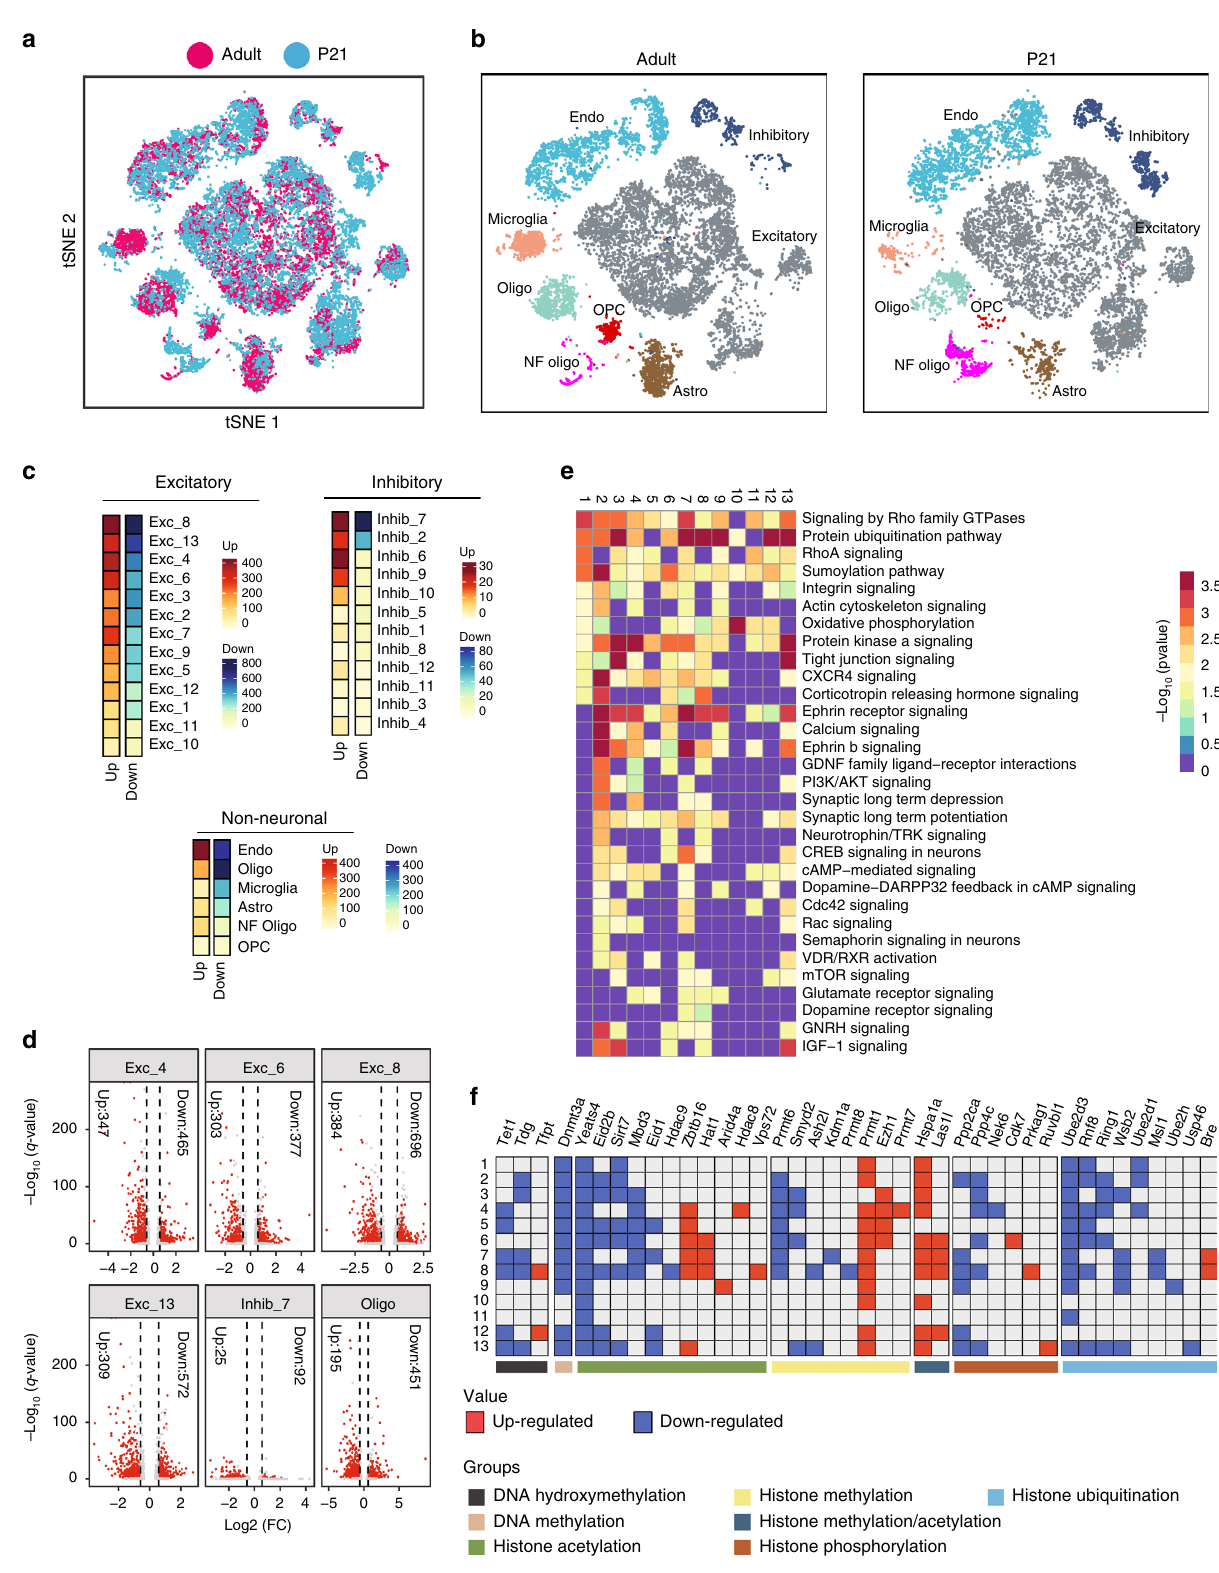
To detect similar populations and identify corresponding cell clusters between the 10,646 P21 cells and the 11, 886 P60 PFC cells, we aligned the two scRNA-seq data sets in t-SNE by cross- correlation analysis (CCA) 17 (Fig. 4a). Using bootstrapped correlation, all clusters identi fi ed in the adult PFC are detected in the P21 PFC (Fig. 4b, see methods), consistent with prior NATURE COMMUNICATIONS| (2019) 10:4169